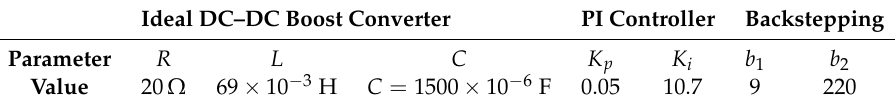
Table 3. Boost converter components and controller